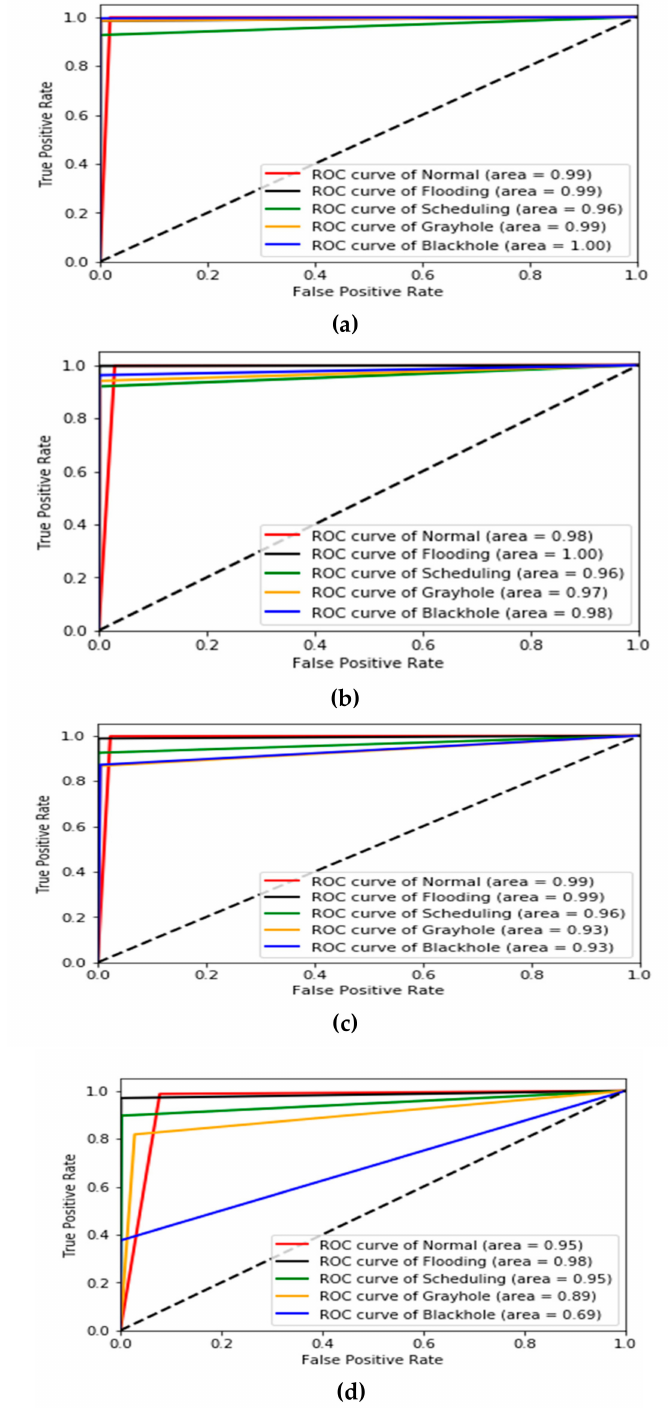
Figure 4. ROC curves for the compared classifiers models: ( a ) ROC curve of GXGBoost, ( b ) ROC curve of XGBoost, ( c ) ROC curve of GB, and ( d ) ROC curve of AdaBoost on the WSN-DS